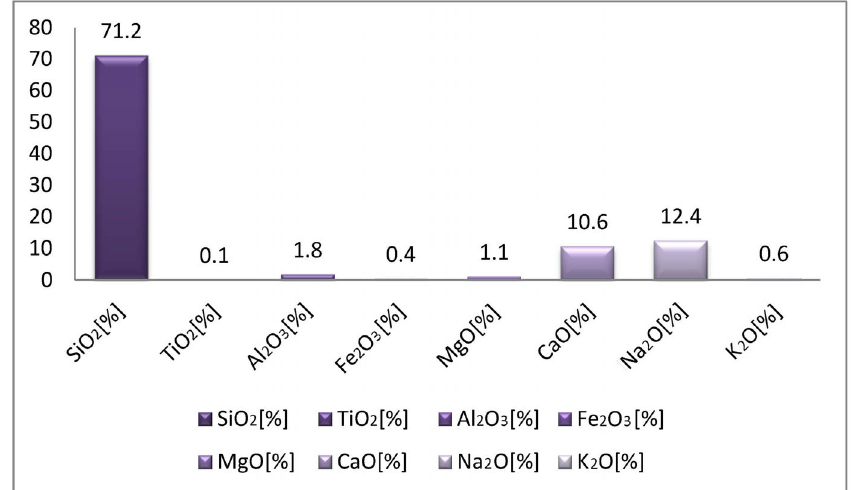
Figure 27. XRF (elemental composition) analysis (oxide composition) of silicate brick modified with glass sand [37].